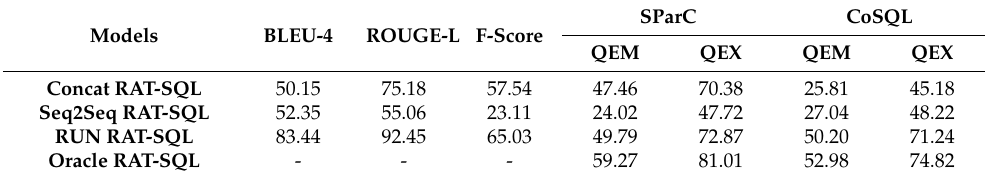
Table 5. QEM accuracy and QEX accuracy of the two-stage models with different rewriting models.